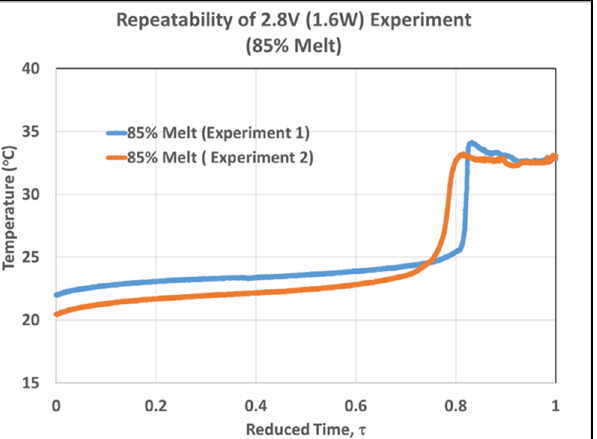
Figure 10. Comparison of temperature profiles in two different experiments for verifying the re- peatability of the experiments: for the thermocouples mounted at the location corresponding to the height of the liquid meniscus for PCM melt-fraction of 85% and for heater input power of 1.6 W (2.8 V input).